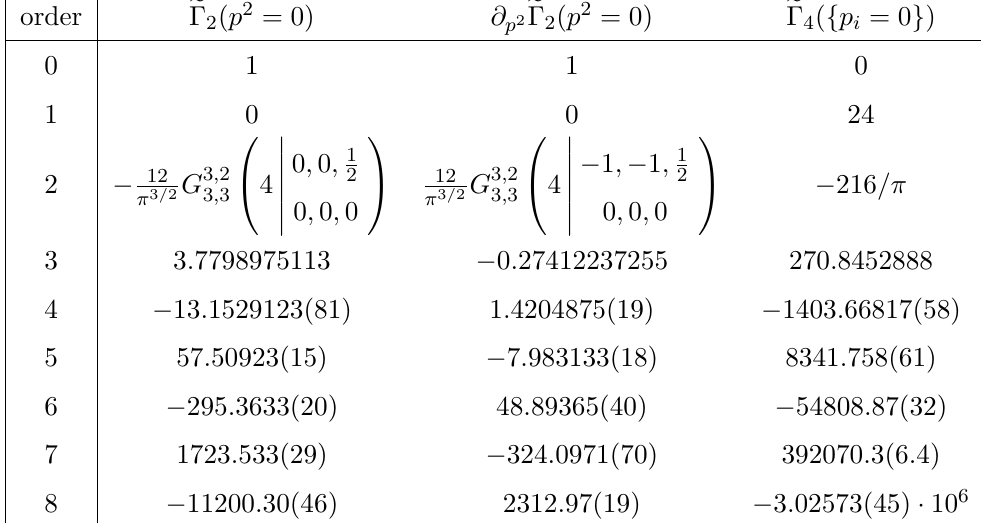
p 2 e (cid:0) 2 and the four